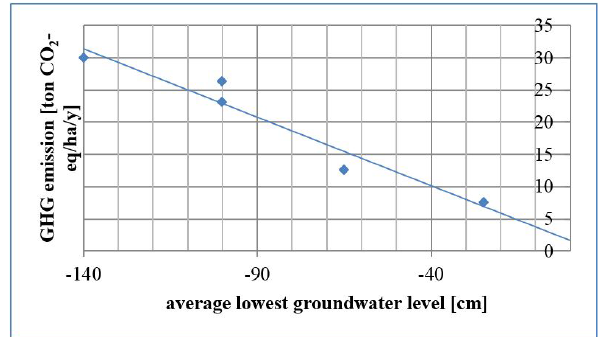
Figure 2. GHG emissions as a function of average lowest ground- water level (Stoffels,